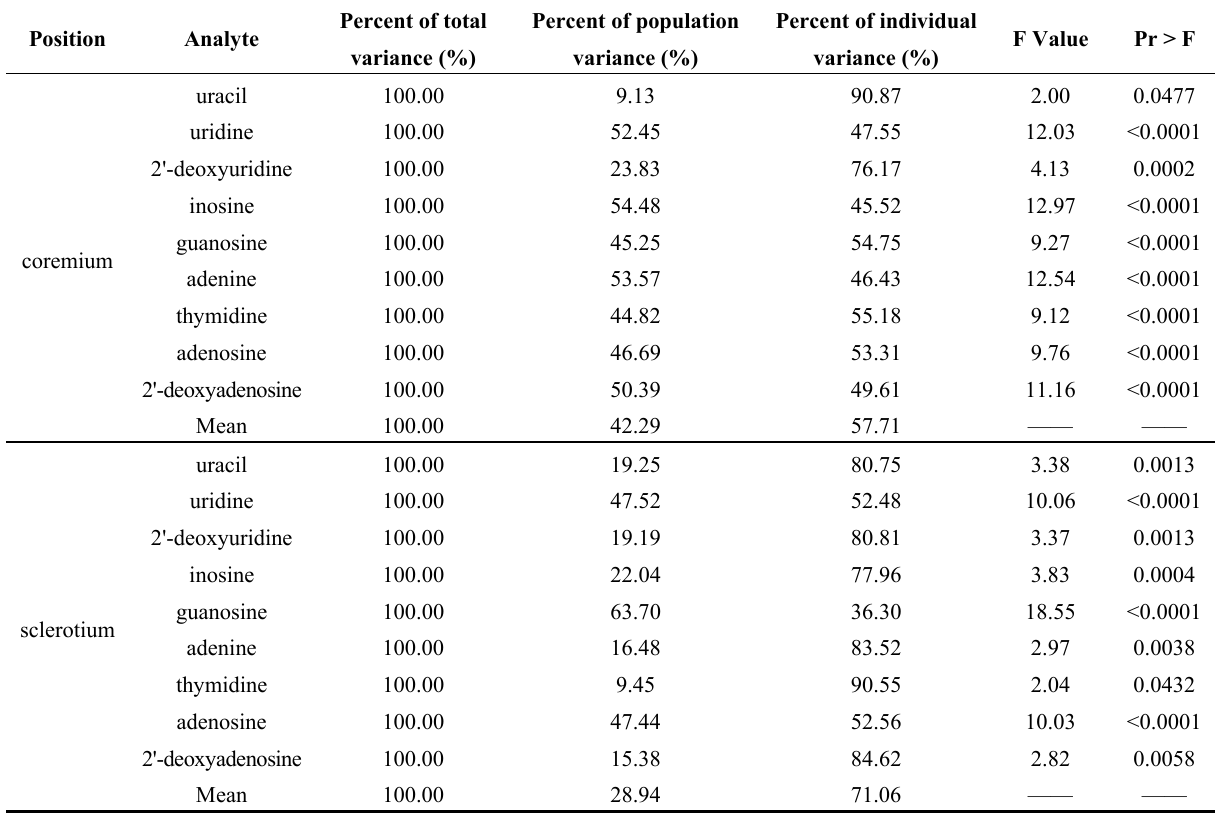
Table 4. Nested analysis of nine nucleosides in coremium and sclerotium of C. cicadae .